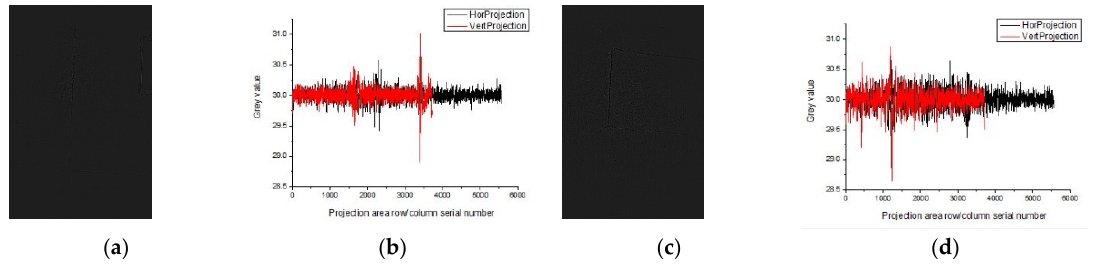
Figure 11. Detection results of step 1 of the crack detection algorithm in Reference [8]: ( a ) Light